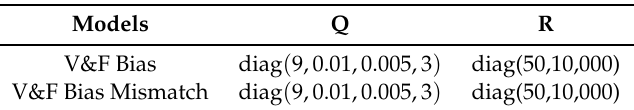
Table 4. Estimation Weights for the different sensors using the simulated data with and without model mismatch. V&F Bias fusion of both sensors without mismatch; V&F Bias Mismatch, fusion of both sensors with model mismatch.